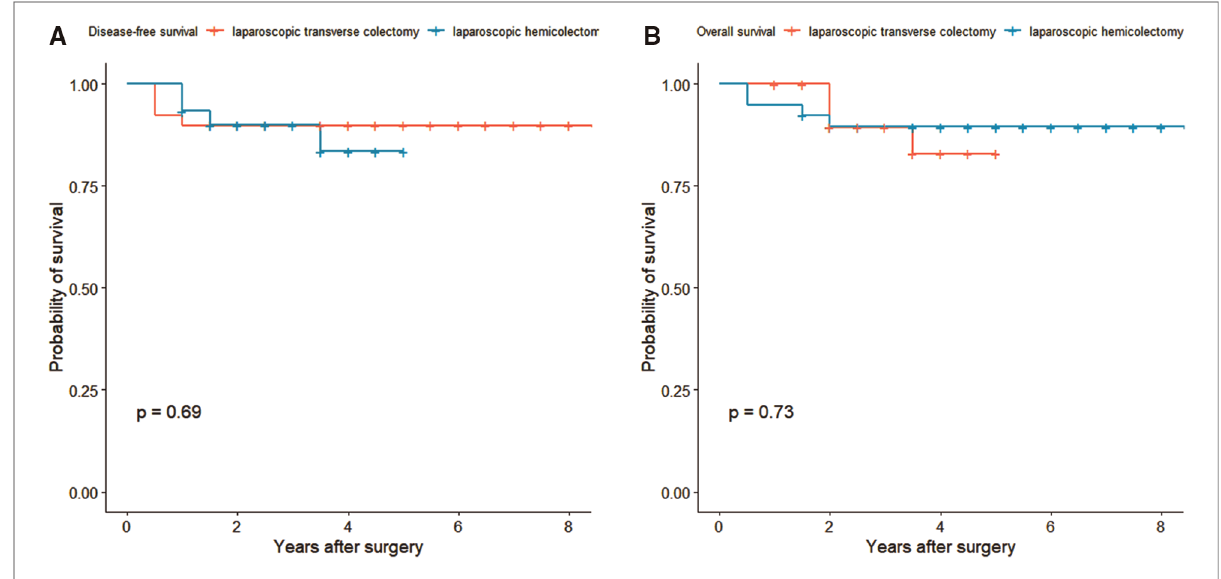
FIGURE 3 ( A ) Disease-free survival of the two groups. ( B ) Overall survival of the two groups.